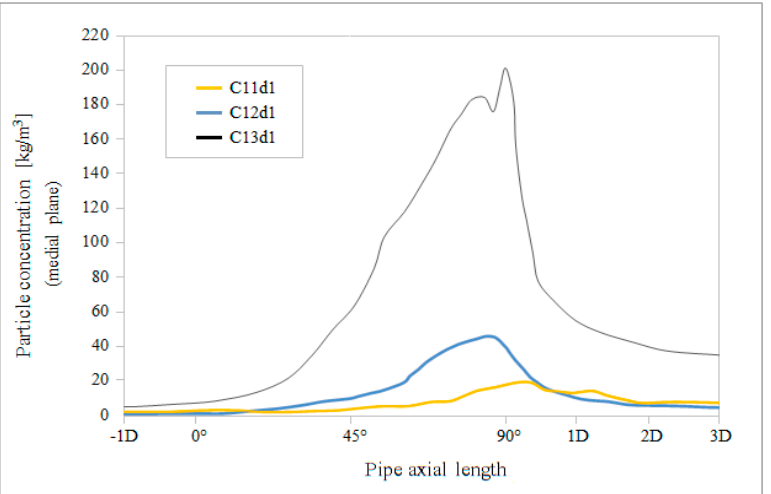
Figure 10. Maximum distribution of concentration in the medial plane of the elbow. Of the cases C11d1, C12d1 (reference case) and C13d1.